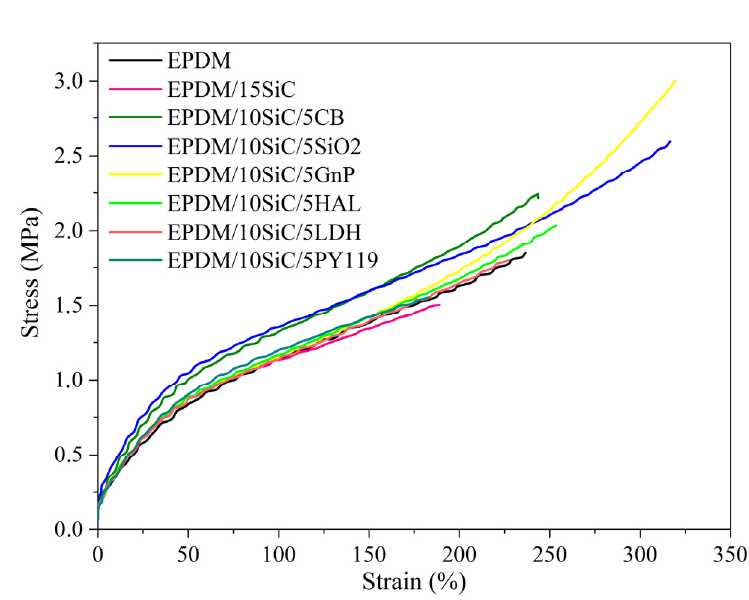
Figure A1. Stress-strain curves of the EPDM composites filled with different hybrid SiC filler systems.